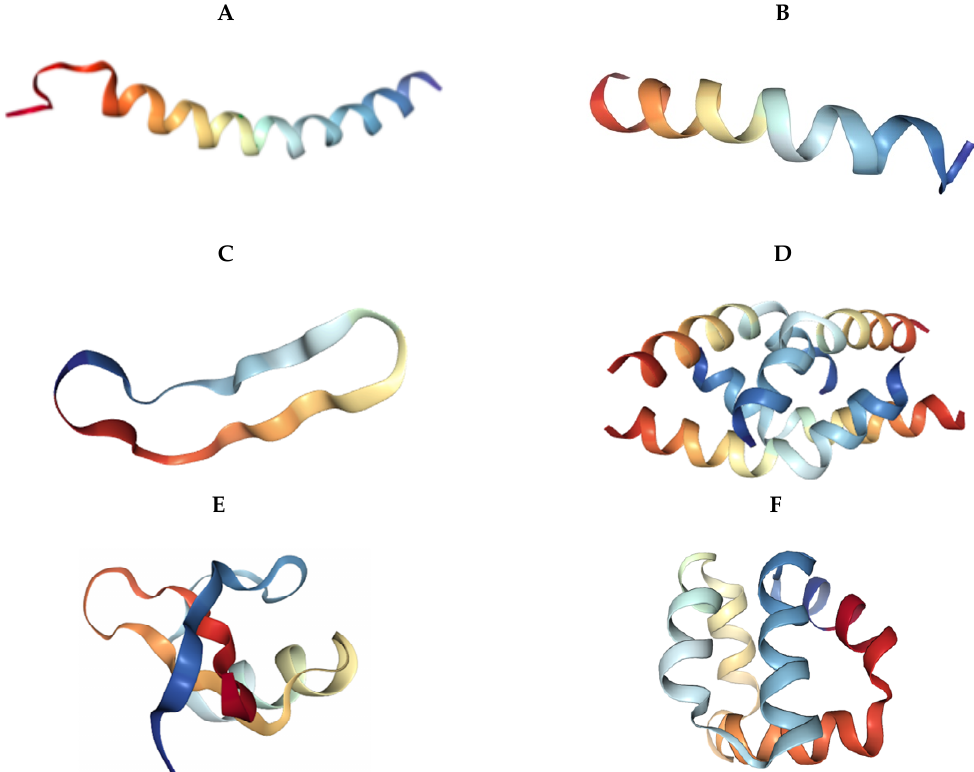
Figure 3. Three-dimensional conformations of natural antimicrobial peptides. Sourced from the Protein Data Bank (https://www.rscb.org). ( A ) LL-37 (Homo sapiens) [26]. ( B ) Magainin-2 ( Xenopus laevis ) [27]. ( C ) RTD-1 ( Rhesus macaque ) [28]. ( D ) Melittin ( Apis mellifera ) [29]. ( E ) TPP3 (Solanum lycopersicum) [30]. ( F ) Bacteriocin AS-48 (Enterococcus faecalis) [31].